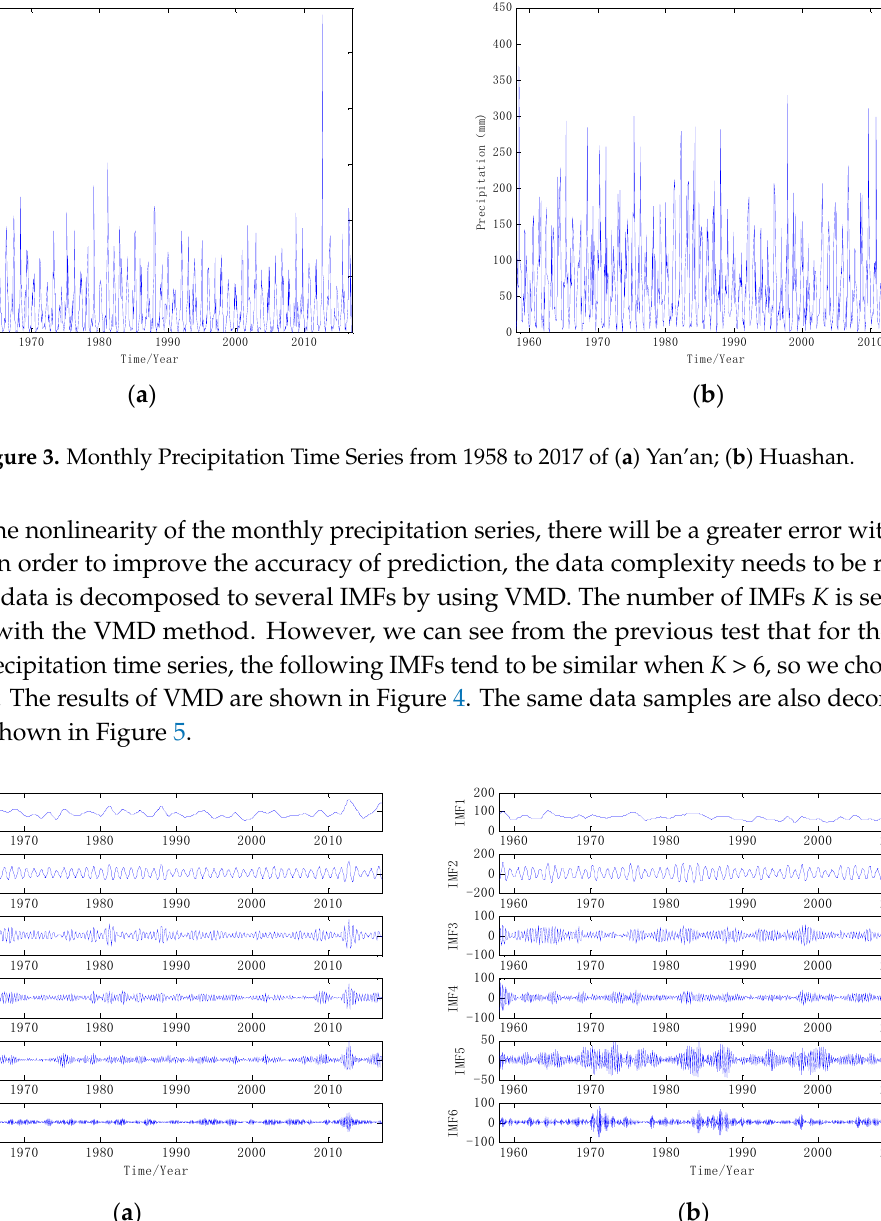
subtropical zone, and it is a continental monsoon climate as a whole. Yan’an City is located in the